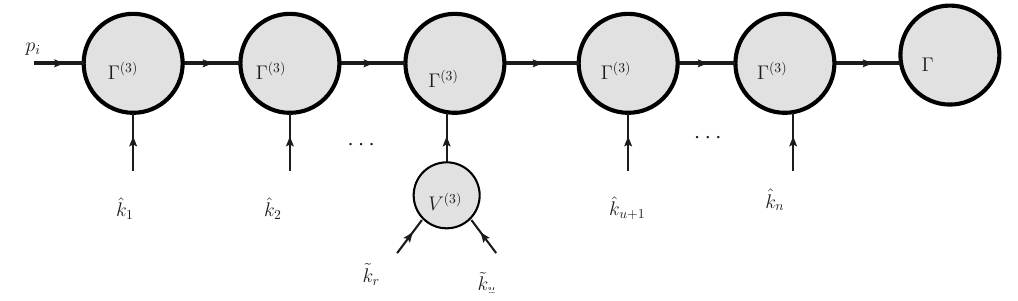
Figure 14 . Diagram contributes in subleading order with two of the soft particles attached via V (3)